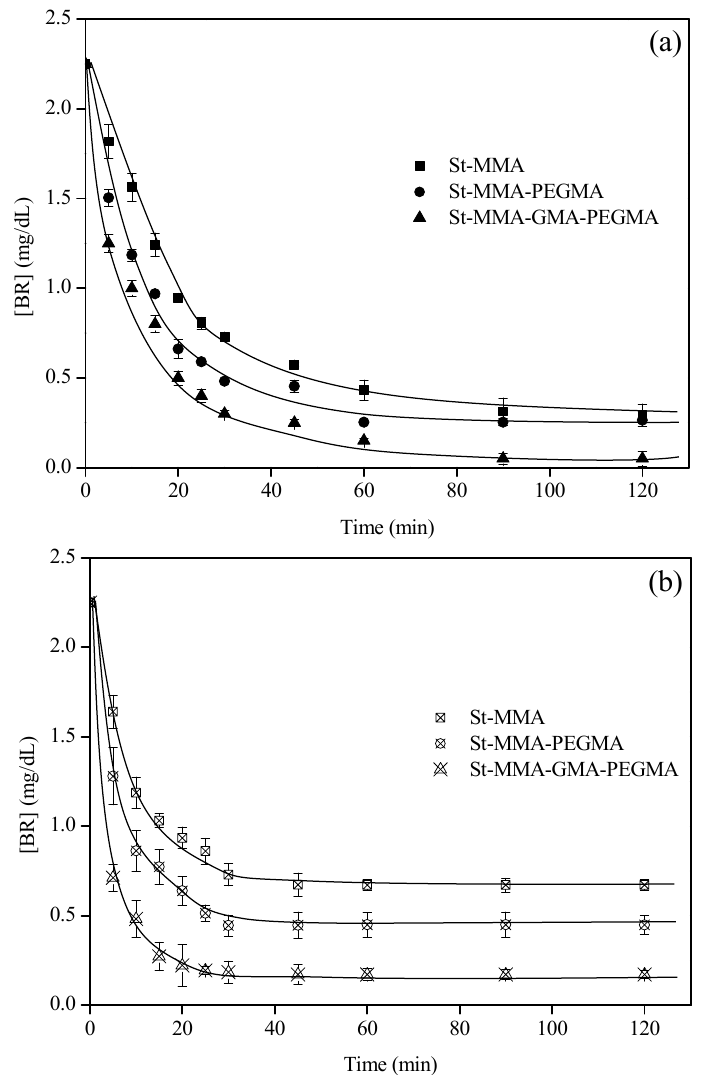
Figure 9. Kinetics of bilirubin removal by ethyl lactate wetted particles without ( a ) and with ( b ) BSA. The experiments were carried out with 2.0 and 1.5 g of particles, respectively. All of the experiments were conducted at 25 °C and with a flow rate of 120 mL/min .